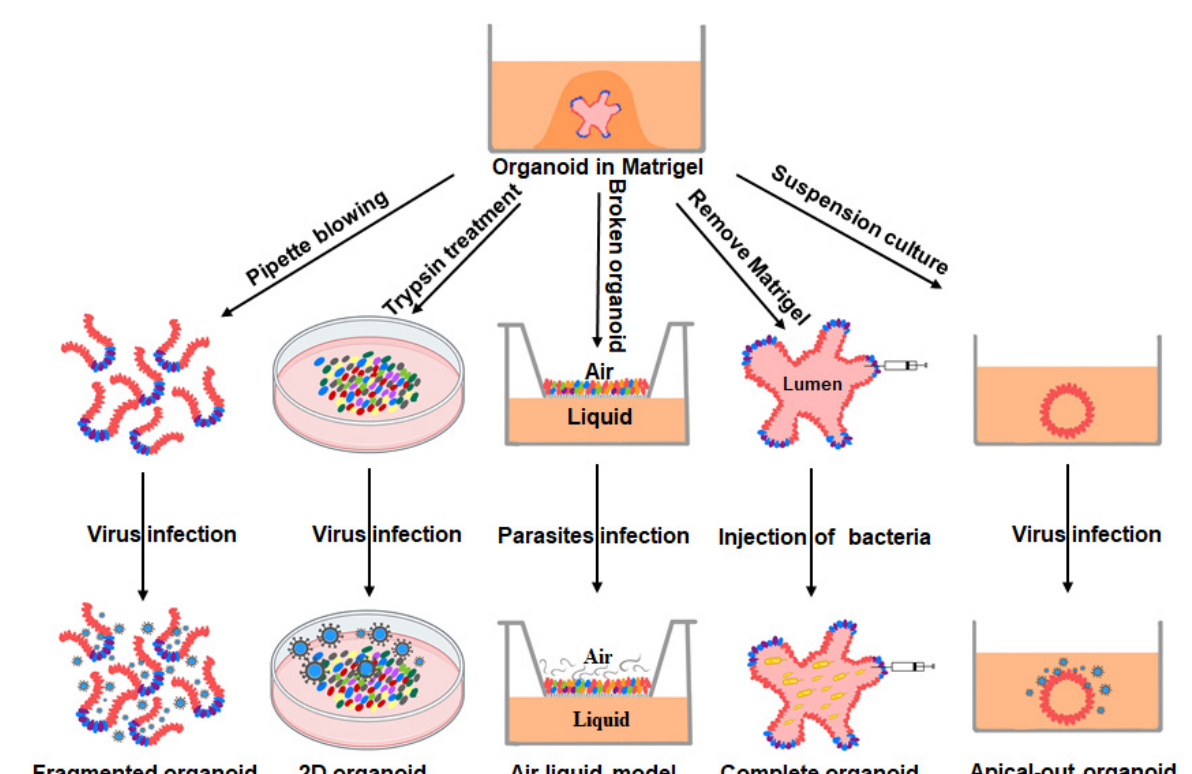
Figure 3. Methods of infecting intestinal organoids with pathogenic microorganisms. The methods of infecting intestinal organoids with pathogenic microorganisms are as follows: (1) blowing apart the intestinal organoids directly to expose the apical membrane and then incubating them with pathogenic microorganisms [45,46]; (2) forming a 2D monolayer by treating the intestinal organoids with trypsin, followed by the addition of pathogenic microorganisms [38,42]; (3) blowing apart the intestinal organoids and then spreading them in a Transwell to form a polarized air–liquid model with multilayer cell accumulation, followed by the addition of pathogenic microorganisms to the air–liquid surface [51]; (4) directly injecting pathogenic microorganisms into the intestinal organoid lumen [52]; (5) exposing the apical membrane inside the intestinal organoid by suspension culturing, followed by infection with pathogenic microorganisms [53].